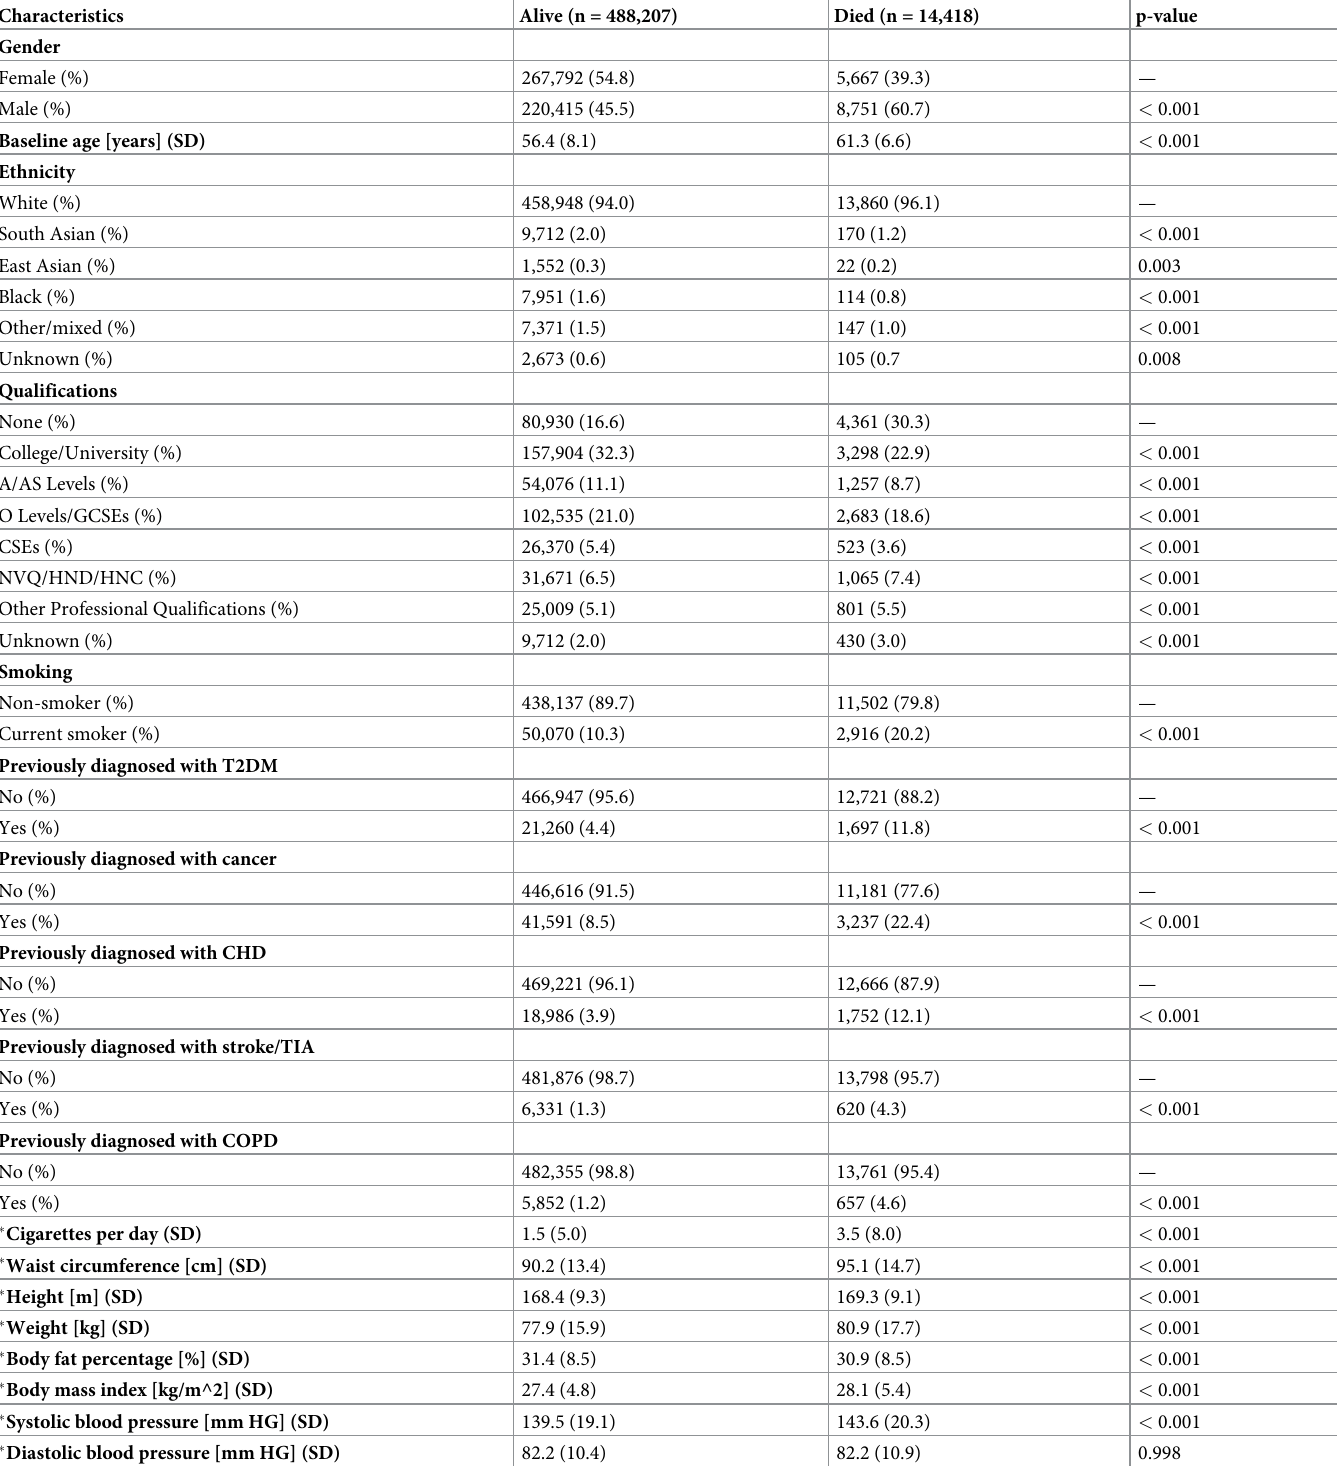
Table 1. Selected baseline characteristics of the study population aged 40–69 years recruited between 2006 to 2010 stratified by mortality during follow-up. Categor- ical variables are numbers and proportions and continuous variables are mean and standard deviations